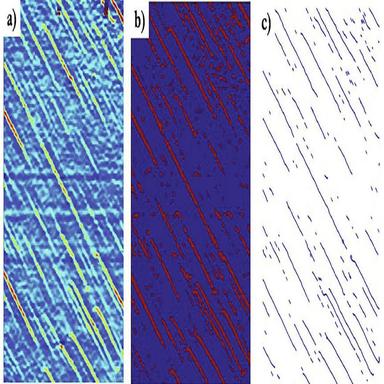
Slice of µCT scan (45x15 mm2 ). Intensity drop along the axial direction at each circular orbit transition.